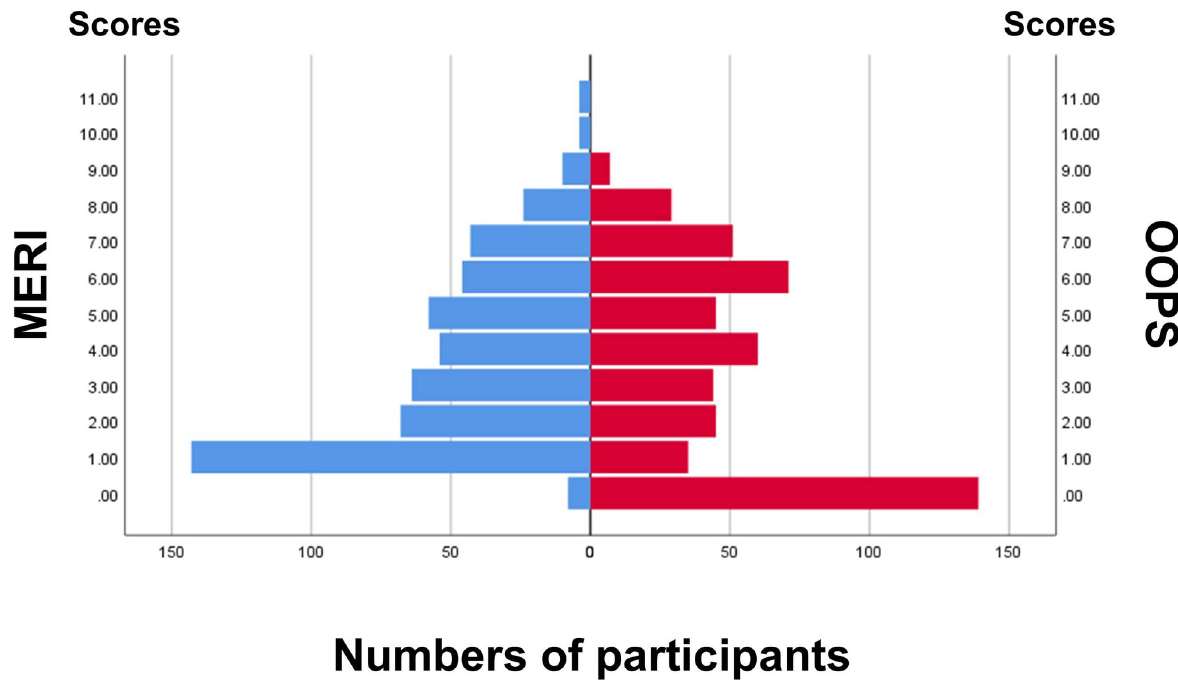
Fig 1. Histogram of MERI and OOPS scores. MERI, middle ear risk index; OOPS, ossiculoplasty outcome parameter